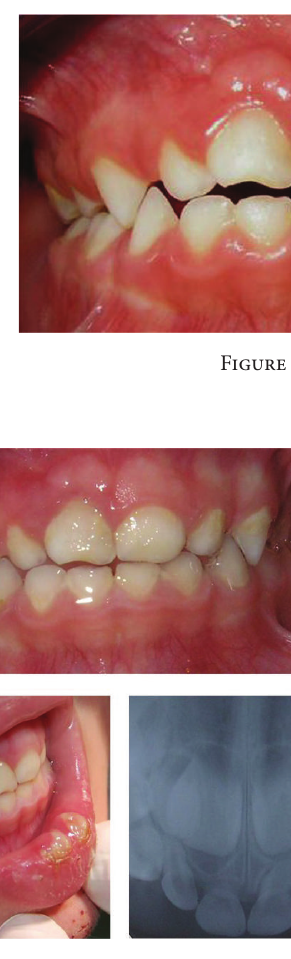
Figure 3: Last trauma.